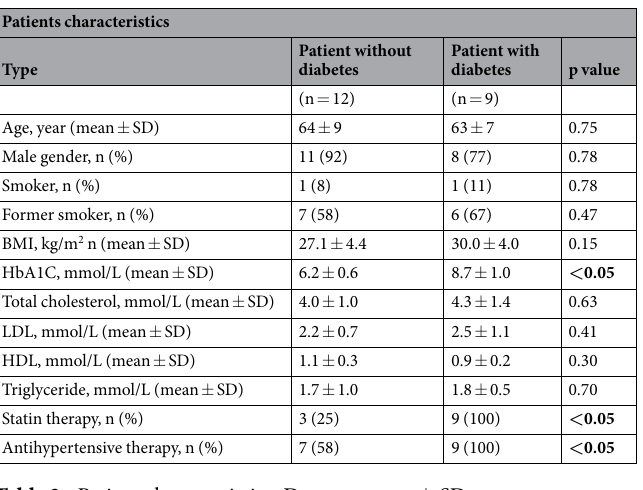
Table 2. Patient characteristics. Data are mean ± SD.